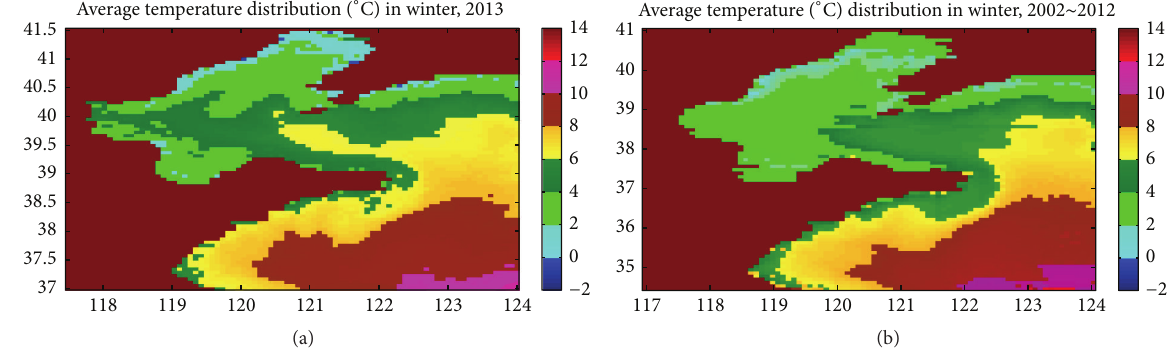
Figure 3: Average SST distribution in winter 2013 (a) and 2002–2012 (b).